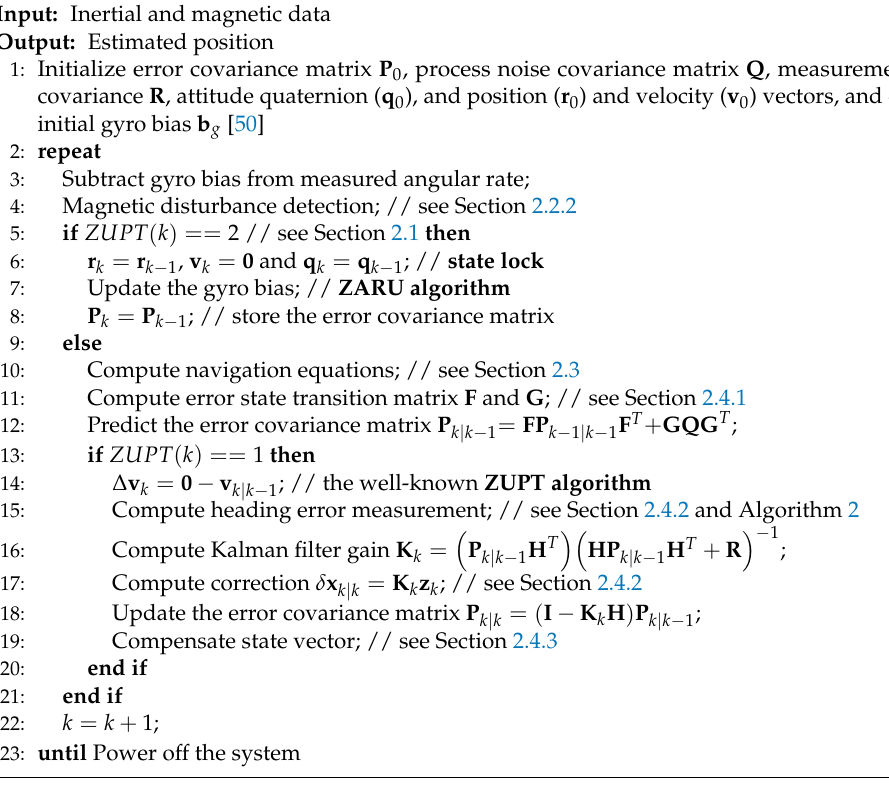
Figure 1. Flowchart of our proposed hybrid framework. Heading error measurement updating and the zero-velocity update (ZUPT) algorithm are triggered by the stance-phase signal from the foot-state classifier (FSC). The zero-angular-rate update (ZARU) algorithm and state lock work once the still phase is detected Algorithm 1 Operation of our proposed